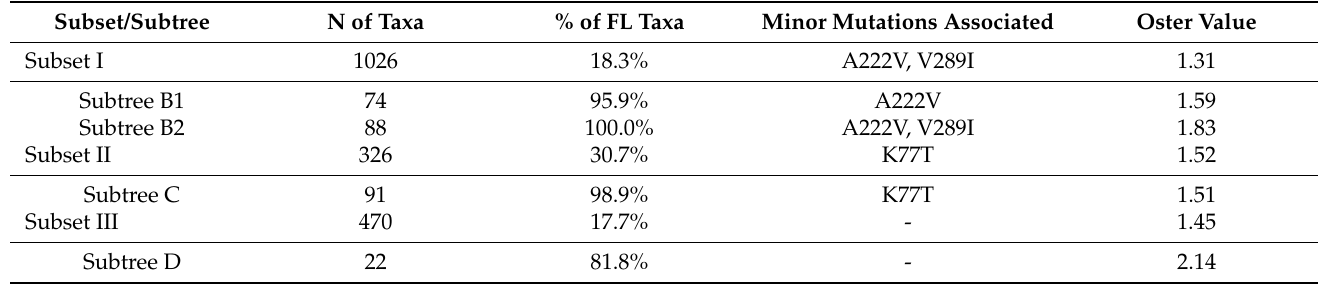
Table 1. Subset/subtree statistics (number of taxa, percentage of FL taxa, minor mutations associated and absolute Oster